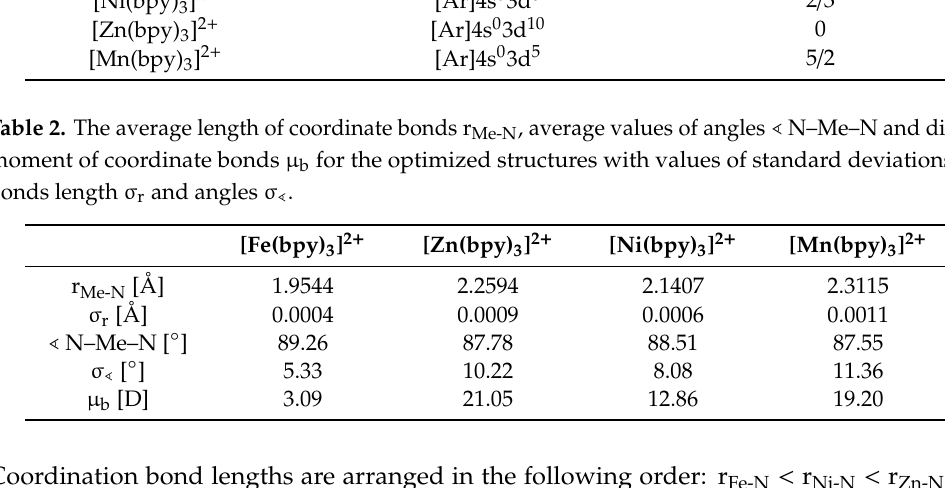
Table 1. The total spins of the complexes in the ground state [33,34].